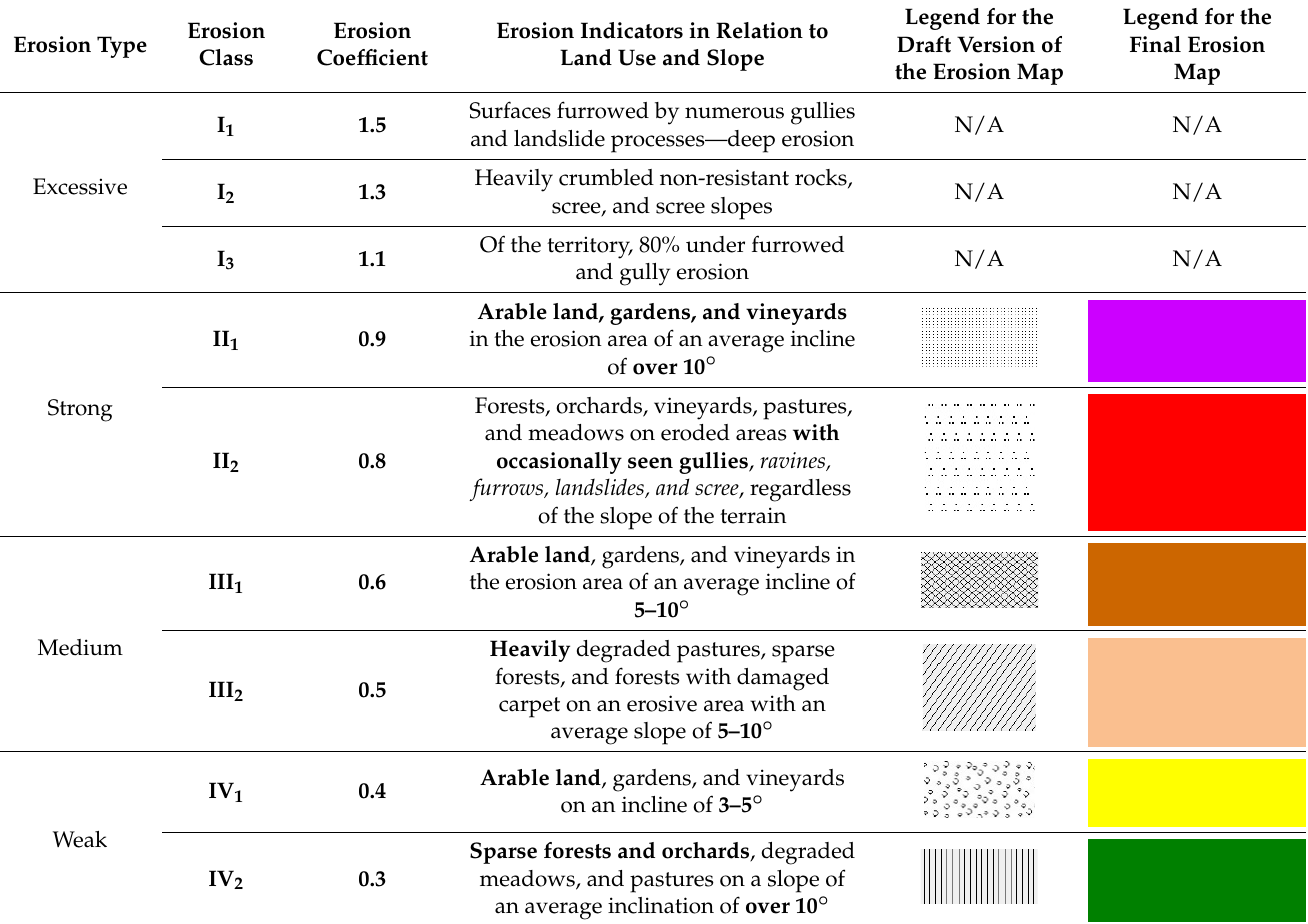
Table 2. Legend symbols for erosion types for the draft version of the erosion map and the final erosion map.